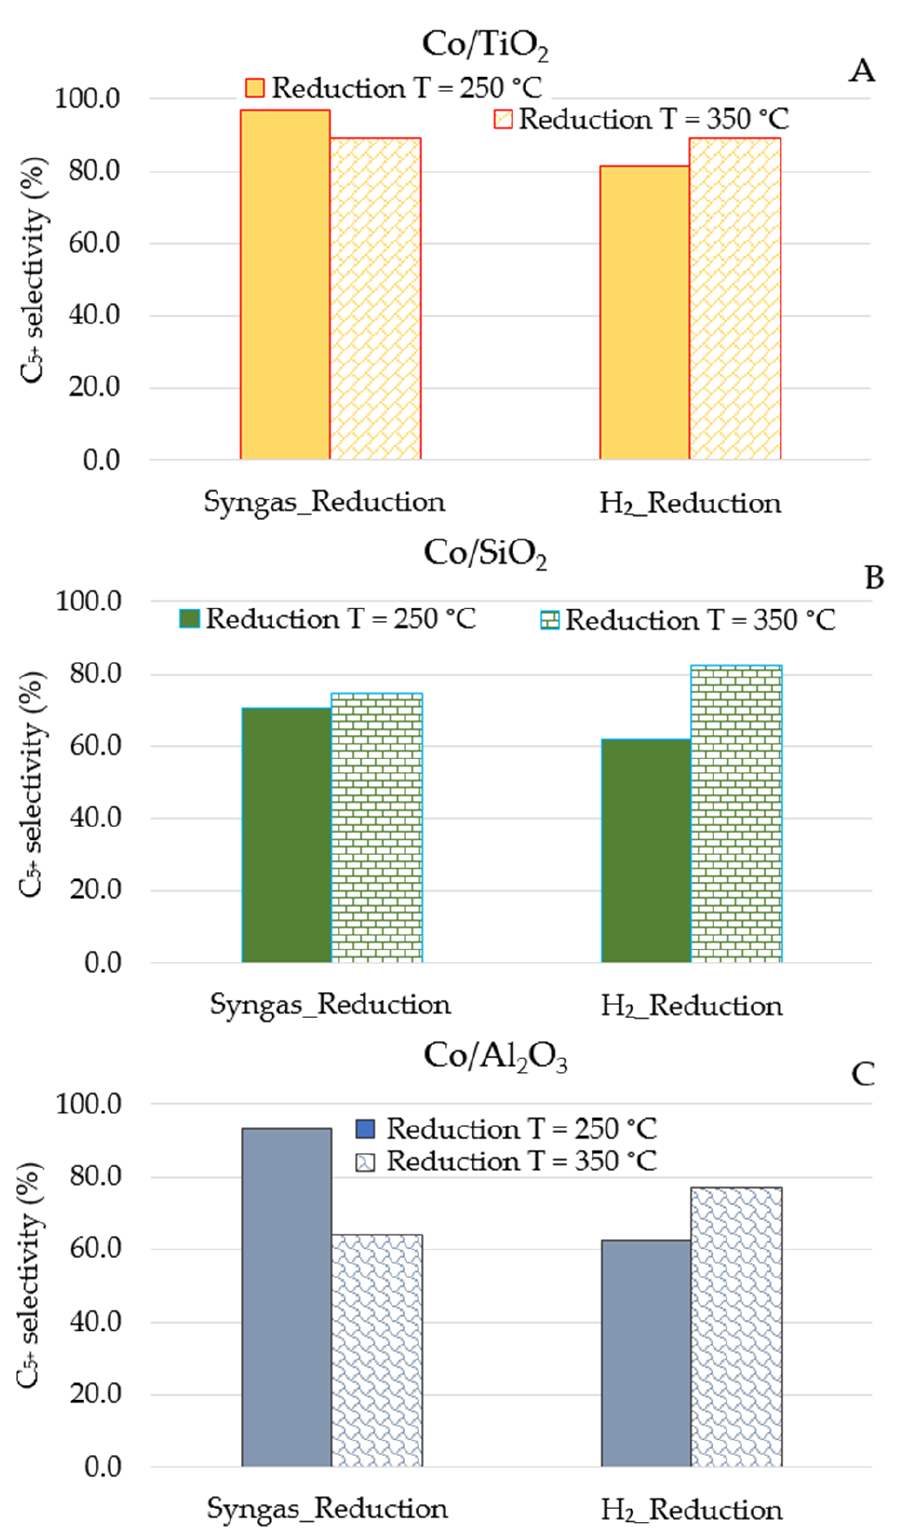
Figure 8. The selectivity of C 5+ as a function of reducing agent and temperature: ( A ) for Co/TiO 2 , ( B ) for Co/SiO 2 , and ( C ) for Co/Al 2 O 3 . Reaction conditions: 20 bar, 60 mL/min, and 210 °C.